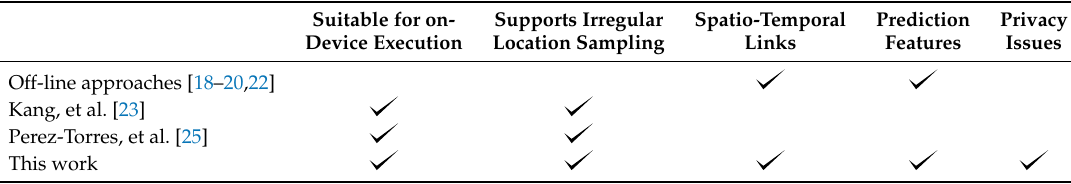
Table 2. A comparison of the features in some proposed solutions for creating maps of human